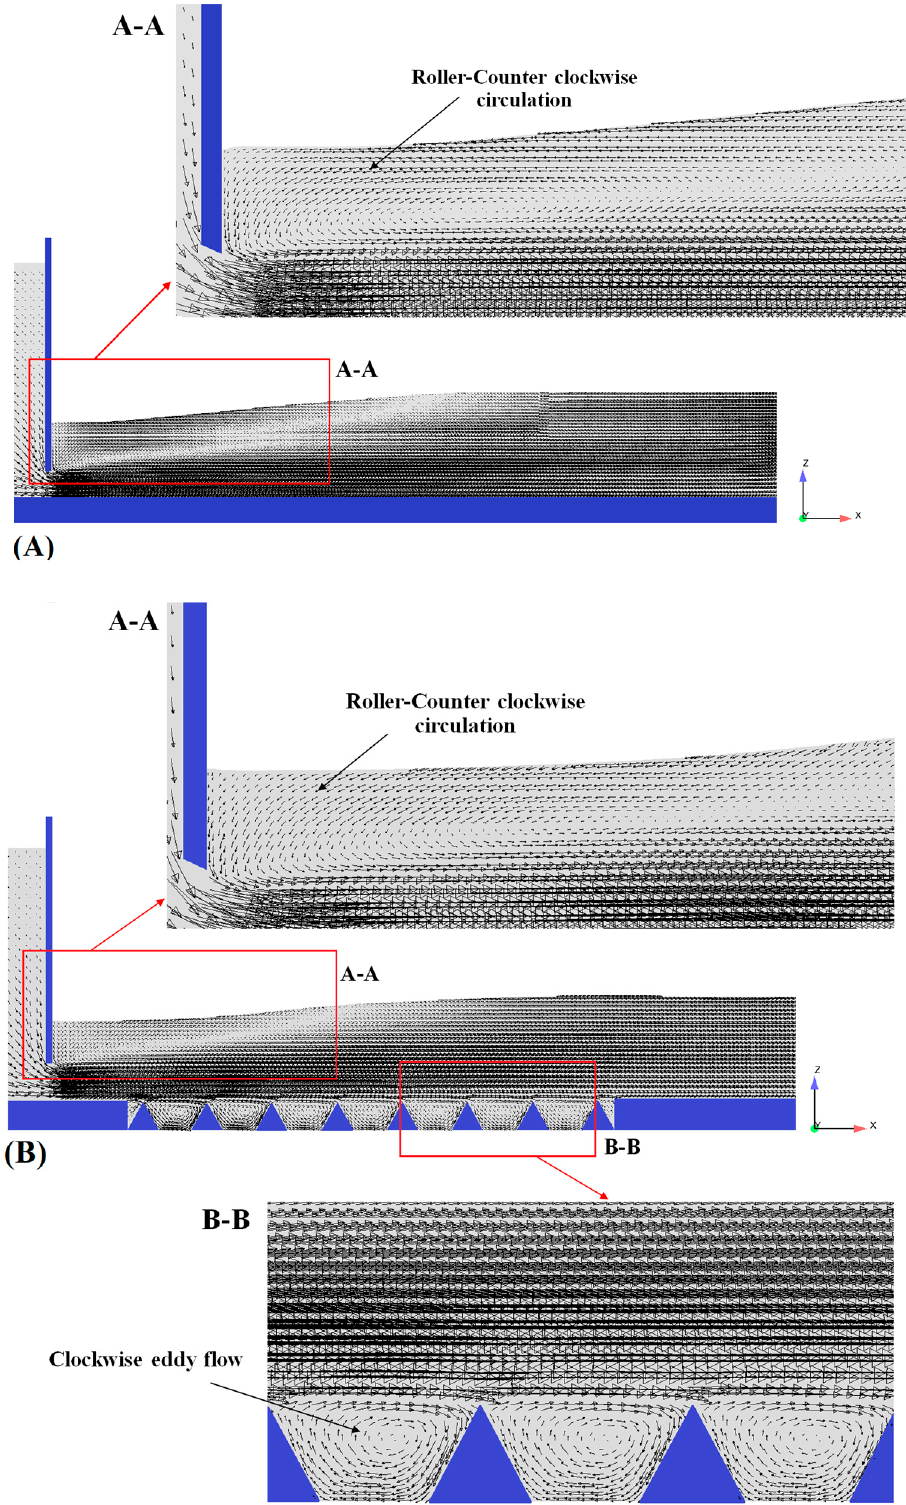
Figure 8. Velocity vector field and flow pattern through the gate in a submerged hydraulic jump condition: ( A ) smooth bed; ( B ) triangular macroroughnesses.